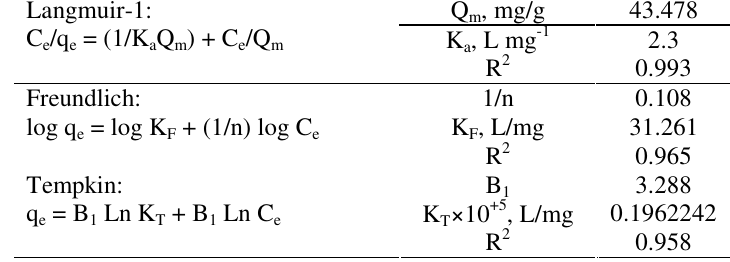
Table 1. Isotherm parameters and correlation coefficients calculated by various